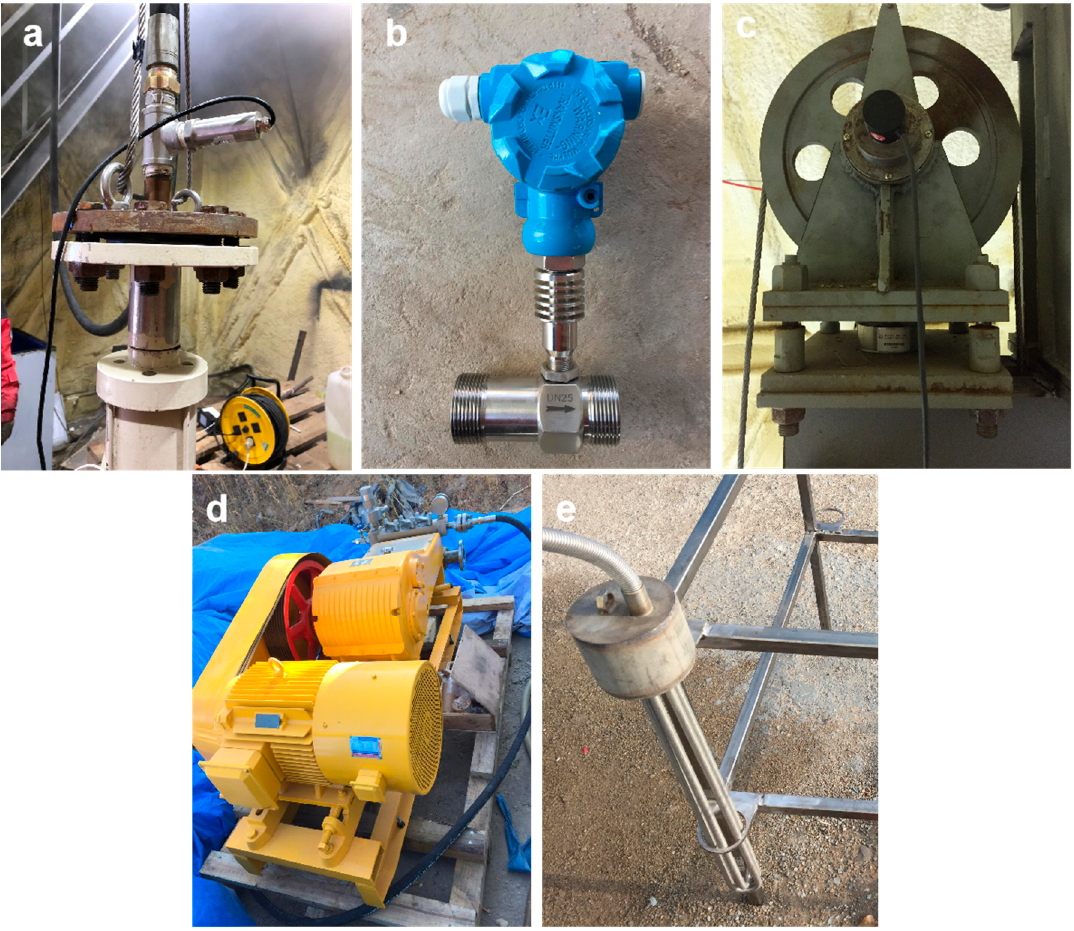
Figure 7. Different kinds of devices: ( a ) temperature sensor; ( b ) flow sensor; ( c ) encoder and load sensor; ( d ) pump; ( e ) heater.